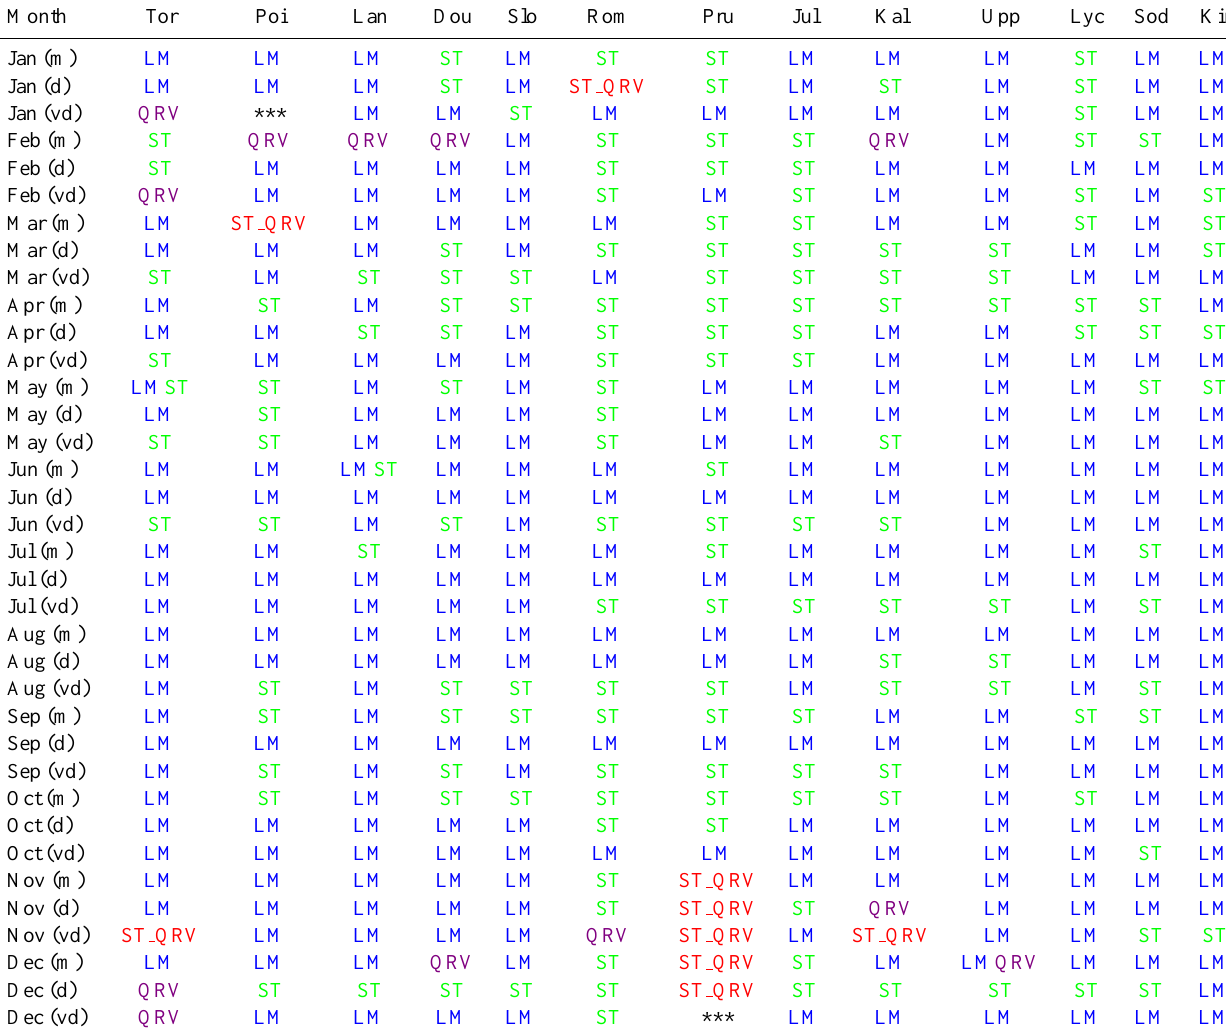
Table 3. The cases in which the local model (indicated with LM), STORM fo F2 MED , IRI (indicated with ST), and STORM fo F2 QT (indicated with ST QRV) models, and the quiet reference values of fo F2 (indicated with QRV) provide the best performance in terms of global r.m.s. error, under moderate (m), disturbed (d), and very disturbed (vd) geomagnetic activity are shown in blue, green, red, and purple, respectively, for all the months and for all the stations. The symbol *** indicates that no data was available to calculate the global r.m.s.